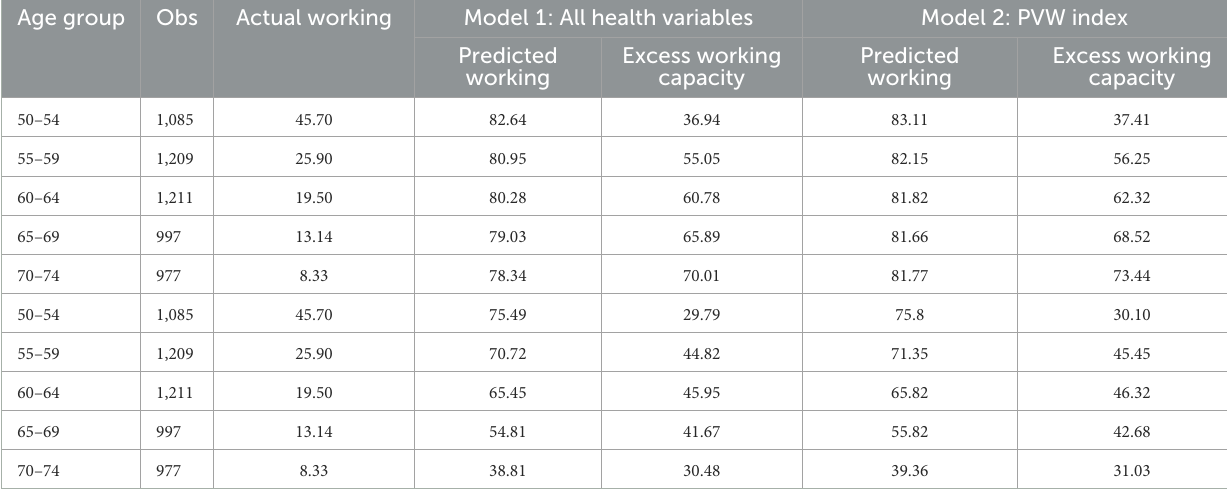
TABLE 5 Calculation of excess work capacity (%): different benchmark. Age group Obs Actual working Model 1: All health